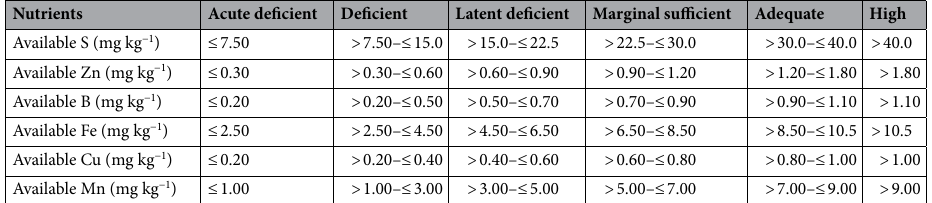
Table 1. Critical limits of available S and micronutrients for agricultural soils of India.